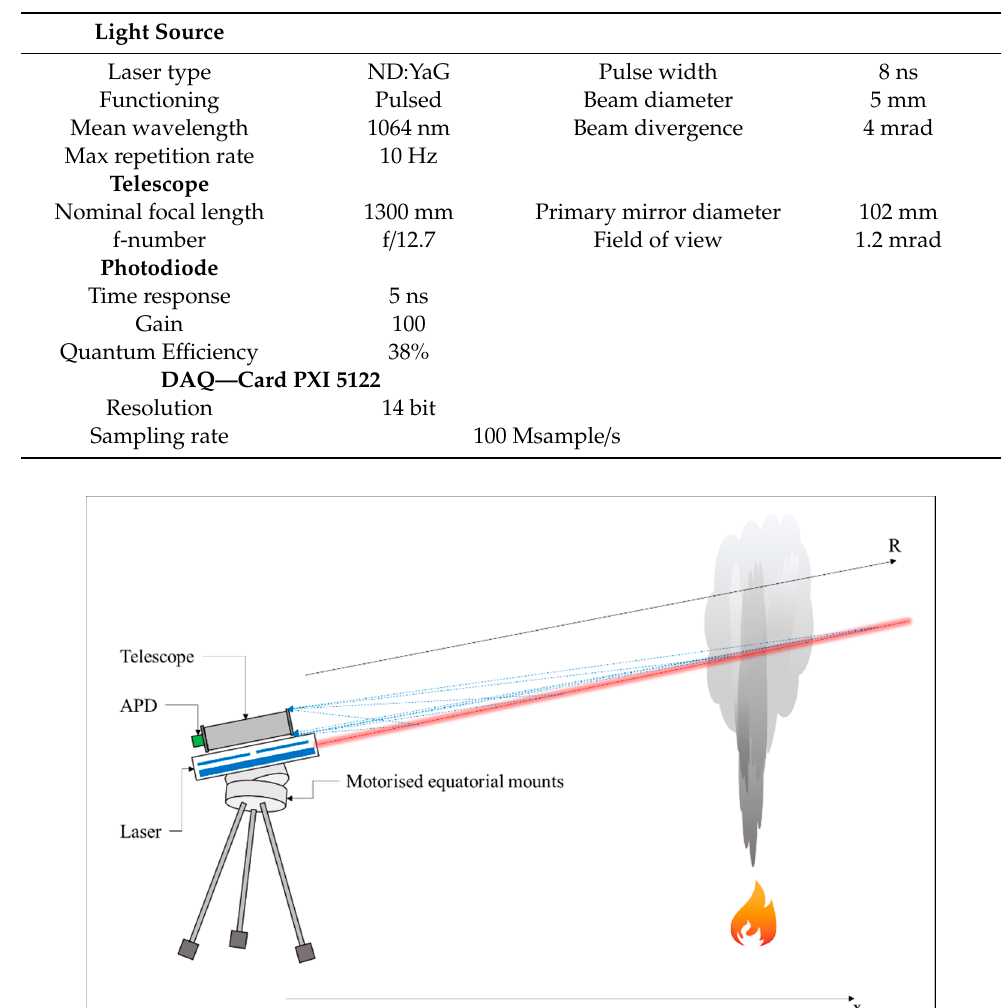
Table 1. Characteristics of LiDAR main components.